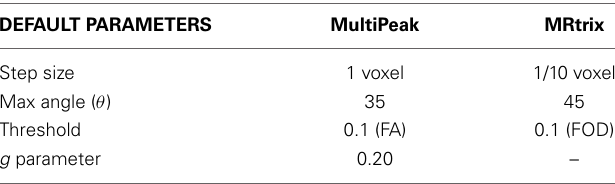
Table 4 | Default tracking parameters used for MultiPeak-RTT and